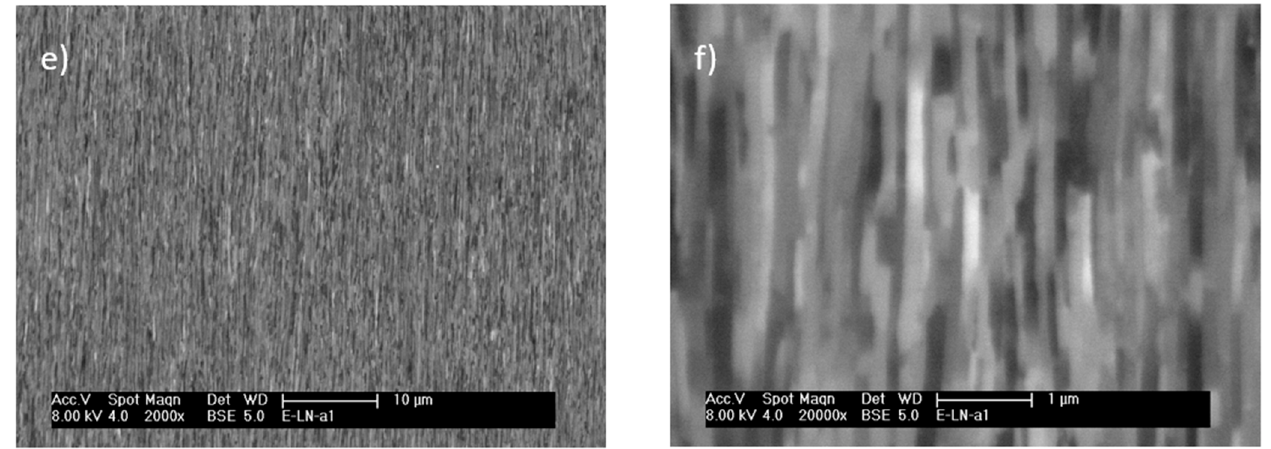
Figure 3. EBS images showing the microstructures on the TD plane obtained after PSC to a true strain of 2.1 at 215 K ( a , b ), 130 K ( c , d ) and 77 K ( e , f ). The compression direction is horizontal.